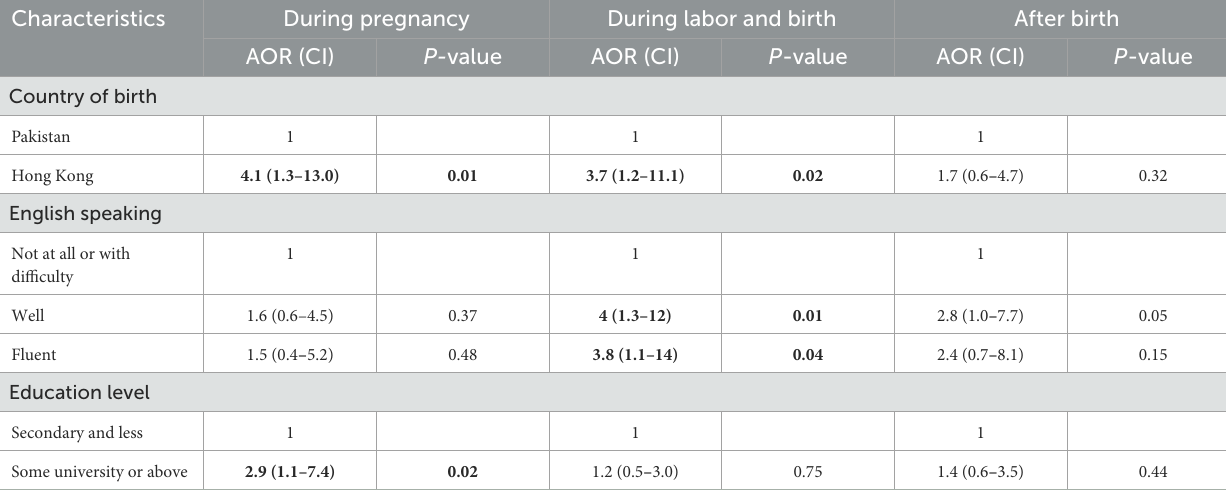
TABLE 5 Multivariable analysis showing AOR for less satisfaction with the overall maternity care services. Characteristics During pregnancy During labor and birth After